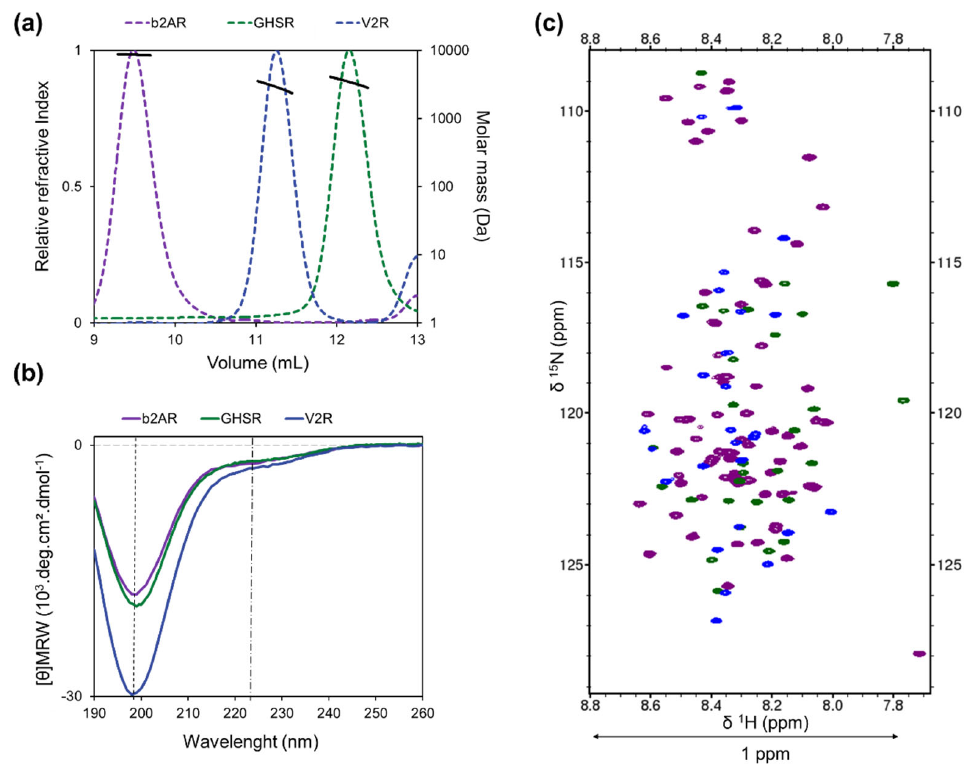
Figure 2. The C-terminal domain of V2R-Cter (blue), GHSR-Cter (green), and β 2AR-Cter (purple) are monomeric and disordered . The color code is maintained for all panels. ( a ) SEC-MALS curves (colored dashed lines). Molar masses derived from MALS are indicated by thick black line (right axis); ( b ) far-UV circular dichroism (CD) spectra (colored lines) present a minimum around 200 nm (black dashed line) and a shoulder at 220 nm (black dashed and dotted line) characteristic of disordered proteins with transient secondary structure content; ( c ) 15 N-HSQC spectra display a low proton spectral dispersion (~1 ppm) typical of IDPs. HSQCs were recorded on 300 µ M samples at 700 MHz and 20 °C, in 50 mM Bis ‐ Tris pH 6.7, 150 mM NaCl buffer.